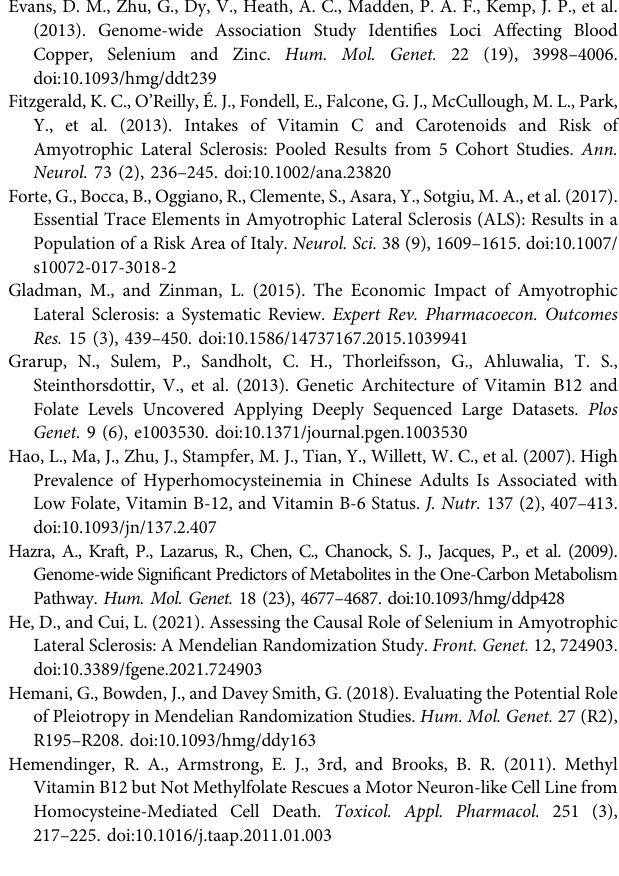
Supplementary Figure 2 | Funnel plots of the causal effects of micronutrients- associated SNPs on ALS risk. (A) vitamin C, (B) vitamin B12, (C) Calcium, (D) Magnesium. Supplementary Figure 3 | Sensitivity analyses of the causal effects of micronutrients-associated SNPs on ALS risk. (A) vitamin C, (B) vitamin B12, (C) Calcium, (D) Magnesium. Supplementary Figure 4| Forest plotsofthe causal effects ofminerals-associated SNPs on ALS risk. (A) Calcium, (B) Magnesium, (C) Copper, (D)